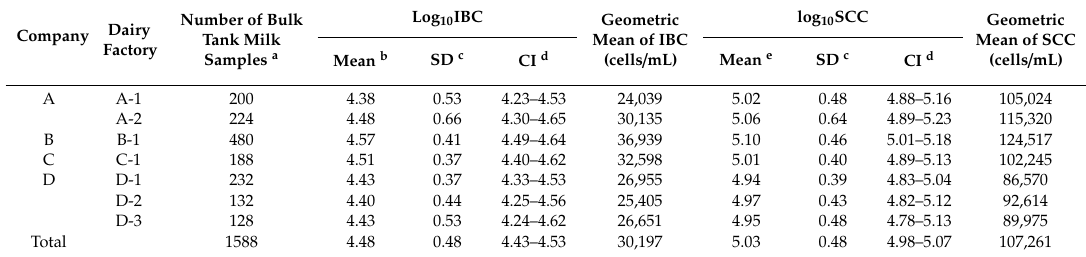
Table 2. Distribution of individual bacterial count (IBC) and somatic cell count (SCC) in bulk tank milk samples from dairy